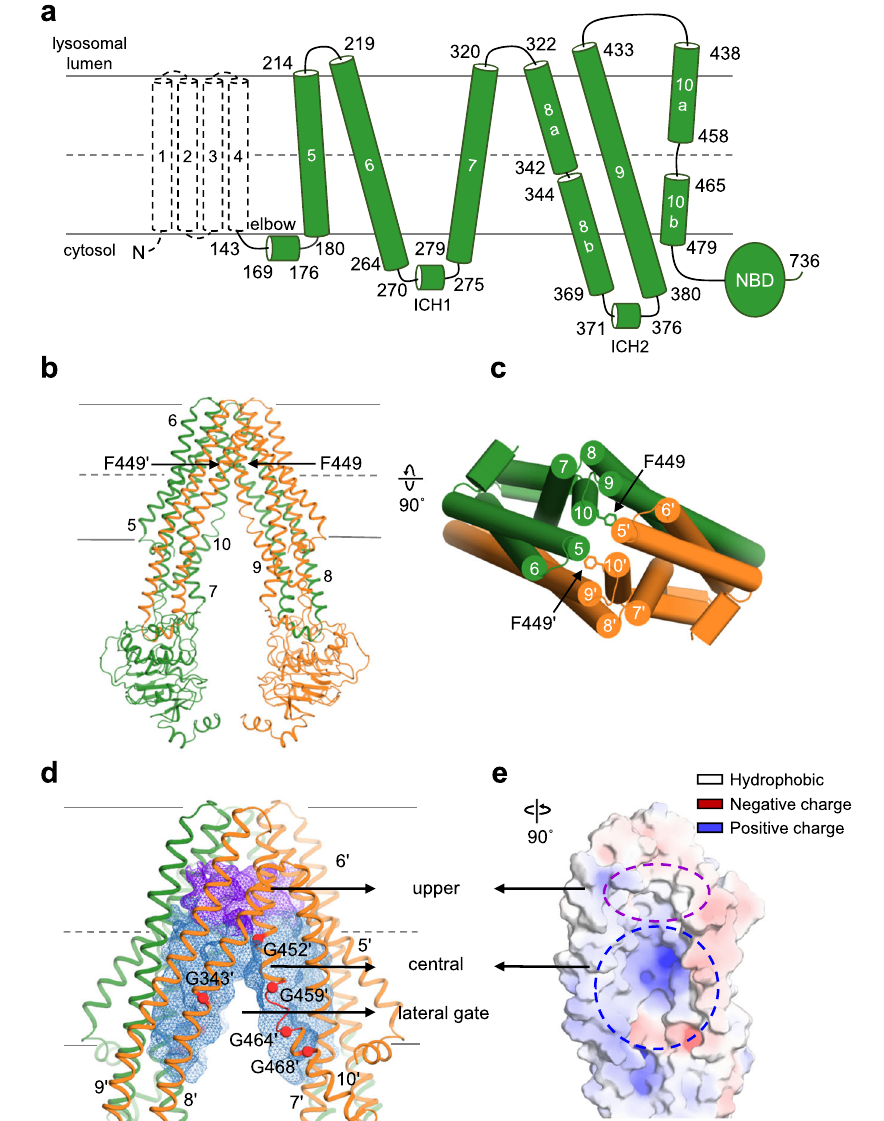
Fig. 3 | The overall structure of nanodisc-reconstituted Δ TMD0 in the inward- facing conformation. a Schematic representation of the mouse TAPL monomer. Dashed lines represent amino acids not included in the fi nal construct. b and c Cartoon or cylinder representation of inward-facing Δ TMD0 in b front and c top view. The two monomers are shown in green and orange, respectively. The F449 residueineachmonomerisshownasastick.Singleprimesareusedfortheresidues (or helices) of one monomer to differentiate them from those of the other monomer. d Thesubstratetranslocationpathwayof Δ TMD0.Theupperandcentral